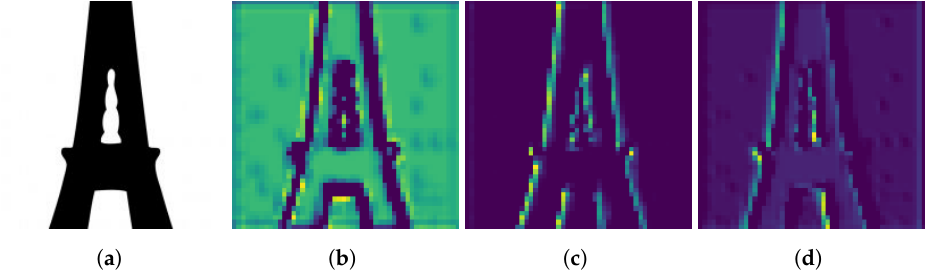
Figure 2. Examples of the activations of selected convolutional filter layers within the VGG-19 neural network for an ( a ) example input. The filters shown exhibit greater activation for ( b ) neighborhood of similar pixels, ( c ) the left outer border of the structure, and ( d ) the right inner border of the